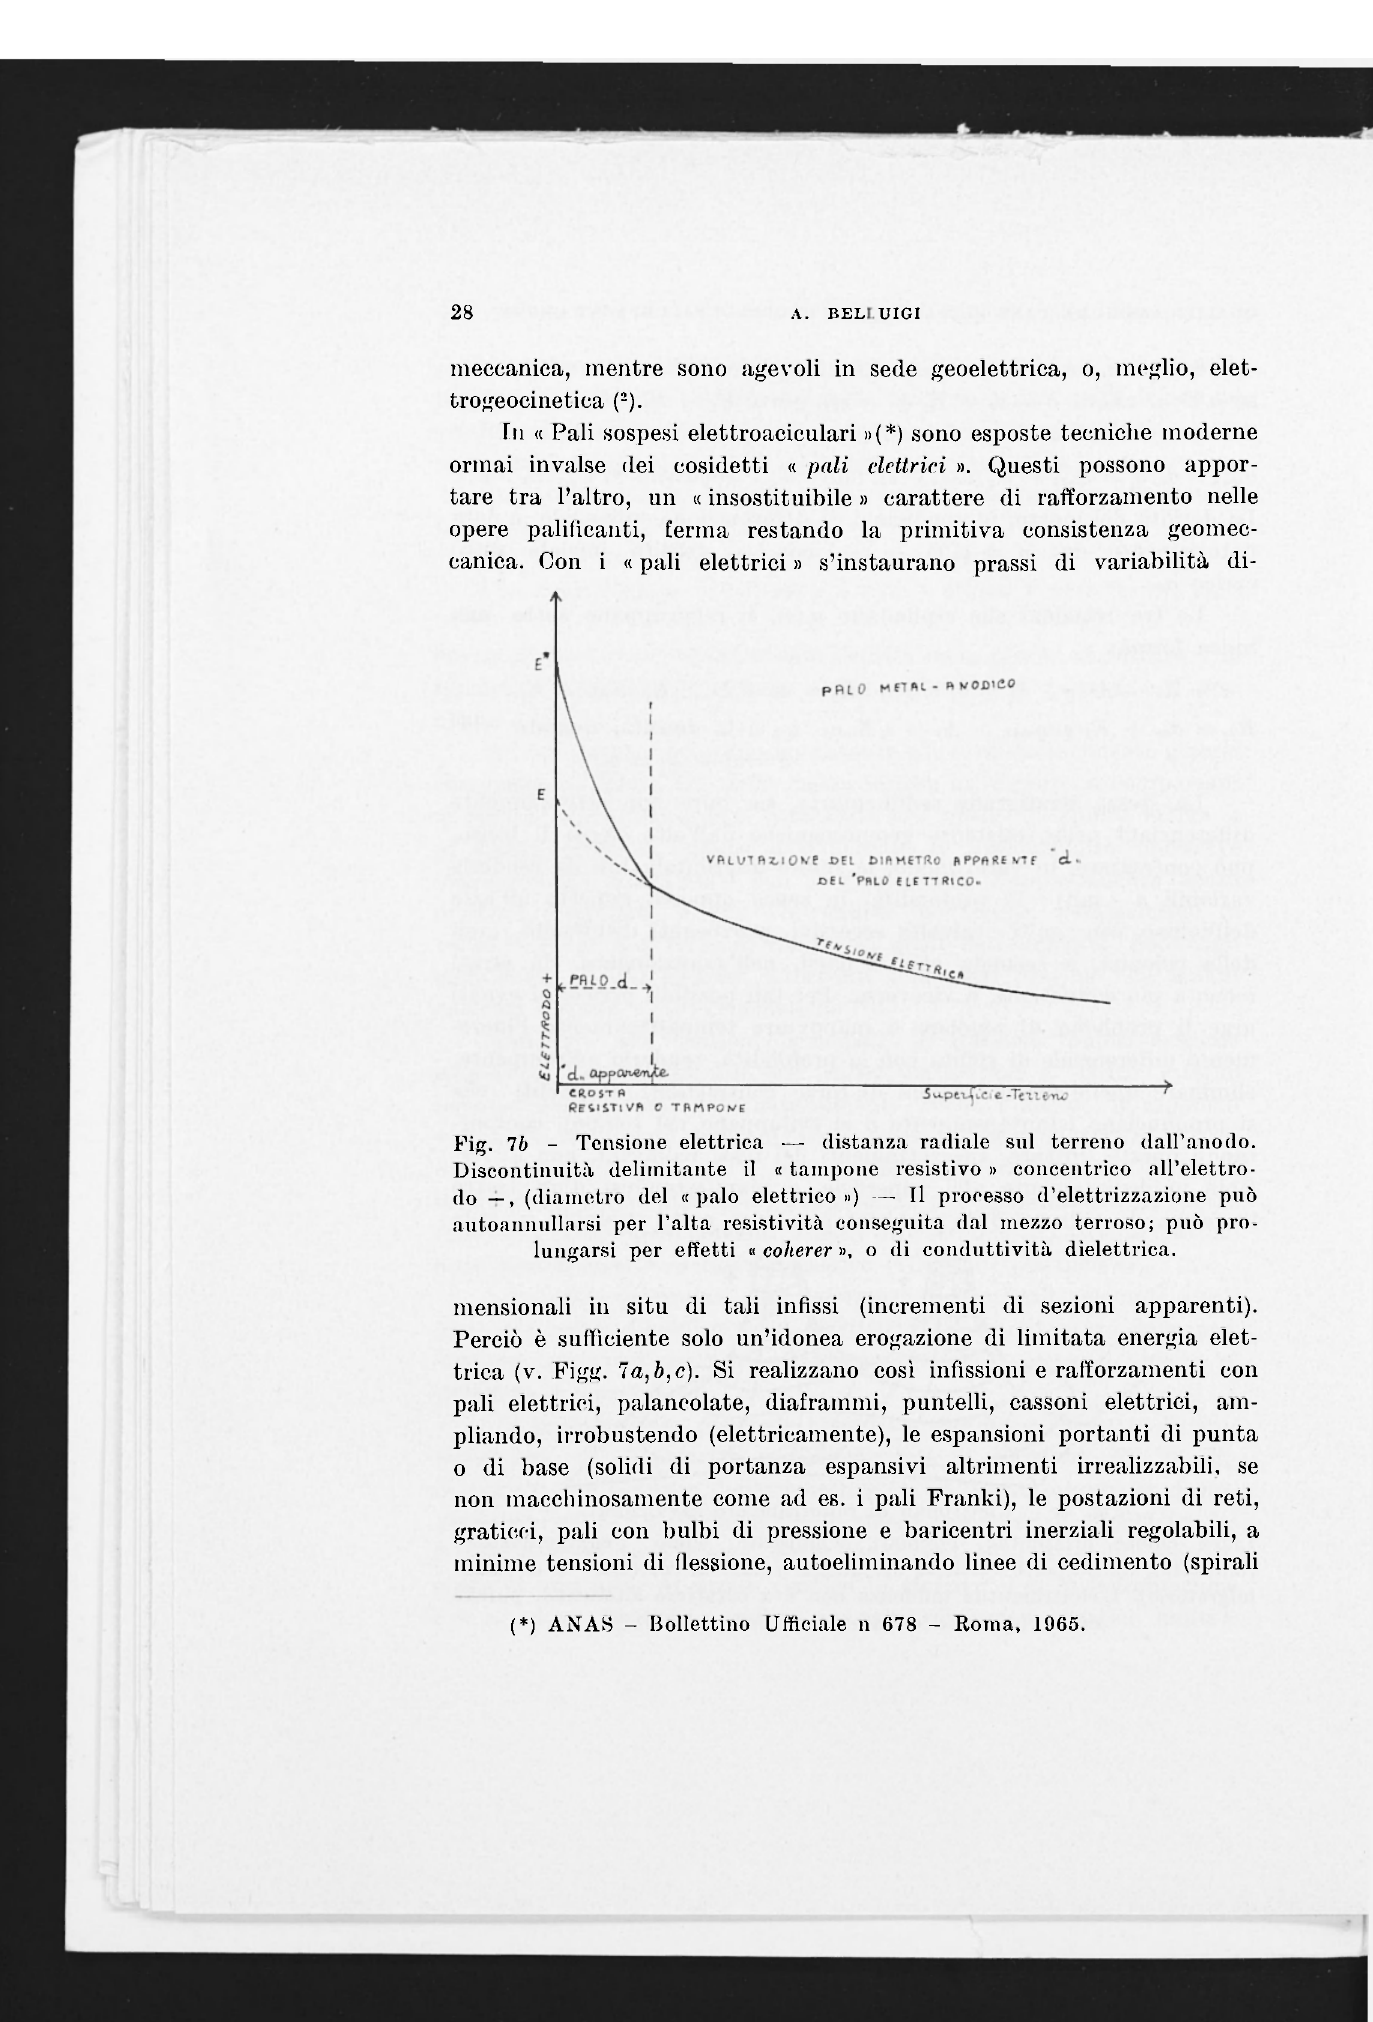
Fig. 76 - Tensione elettrica — distanza radiale sul terreno dall'anodo. Discontinuità delimitante il « tampone resistivo » concentrico all'elettro- do — , (diametro del «palo elettrico») — Il processo d'elettrizzazione può autoannullarsi per l'alta resistività conseguita dal mezzo terroso; può pro- lungarsi per effetti « coherer », o di conduttività dielettrica. mensionali in situ di tali infissi (incrementi di sezioni